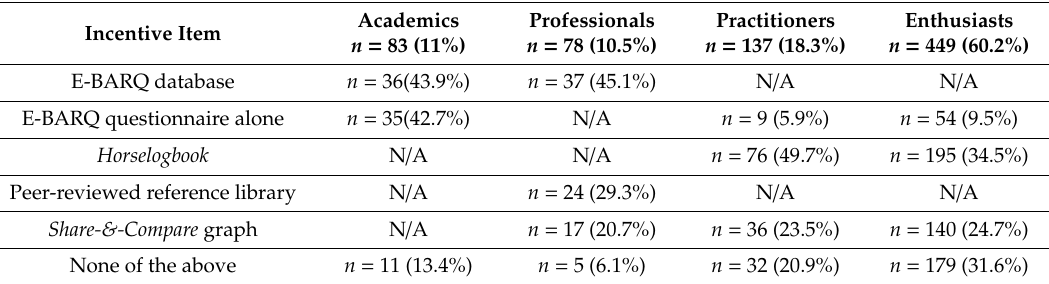
Table 1. The distribution of respondents from four stakeholder groups that were o ff ered tools based on their anticipated appeal (and percentage of that stakeholder group) that indicated which incentive item, or ‘none’, they would find most useful, in a forced single-choice answer. N / A indicates that tool was not o ff ered to that stakeholder